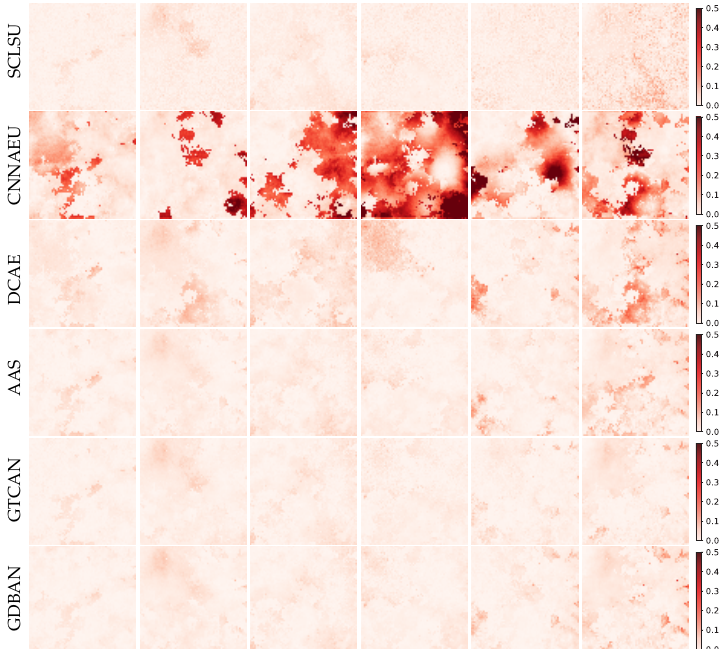
Figure 4. Absolute error maps of the estimated abundances on synthetic data by different